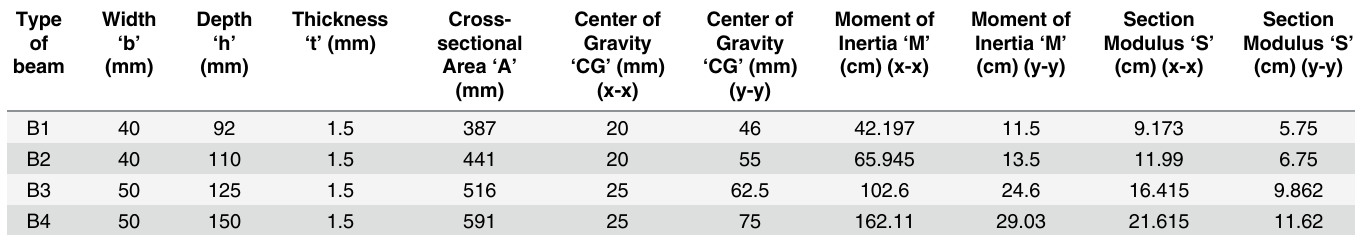
Table 3. Dimension details and section properties of